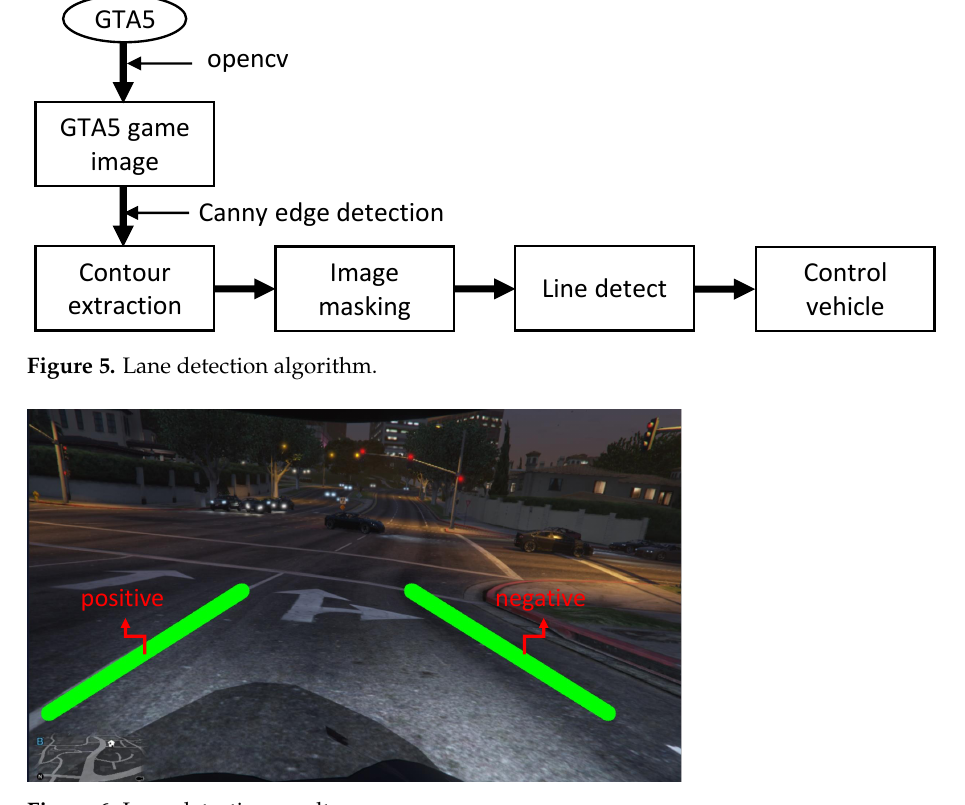
Figure 6. Lane detection result. Algorithm 2: Pseudo code of lane detection algorithm-line